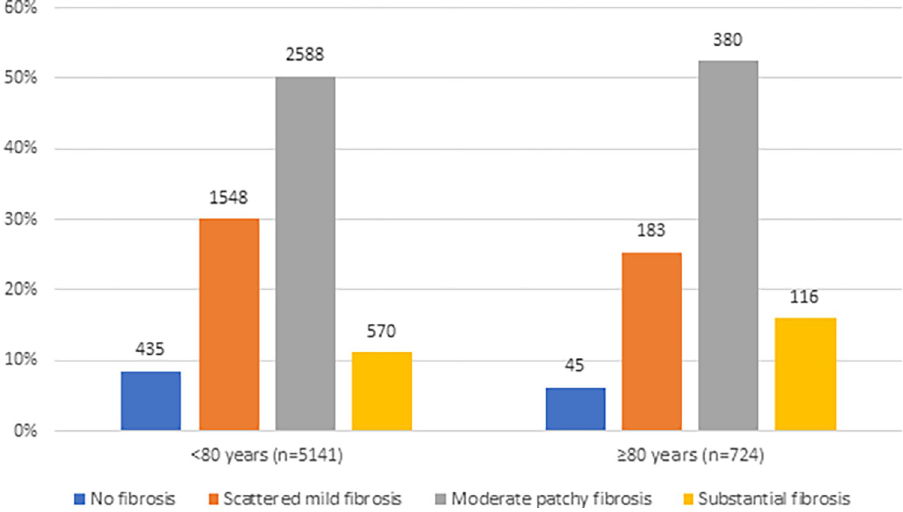
Fig 3. Degree of myocardial fibrosis in < 80 years old and � 80 years old sudden cardiac death (SCD) victims. SCD victims � 80 years old had more commonly worse stage of fibrosis than < 80 years old (P < .001). Percentages represent a proportion of cases in each age group seperately. Values over the bars represent the number of cases in the age